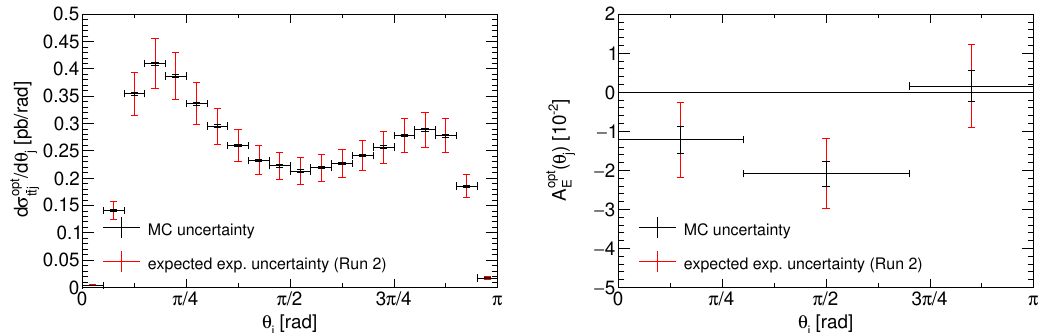
Figure 2 . Particle-level predictions of the di(cid:11)erential cross section d(cid:27) opt =d(cid:18) j in the single lepton t (cid:22) tj channel (left) and the energy asymmetry A opt (right) in three bins of (cid:18) j . The black vertical error bars E show the statistical Monte-Carlo uncertainty of the prediction due to limited number of generated events. The red vertical error bars show the expected experimental uncertainties in a future LHC measurement with 139 fb (cid:0) 1 of Run-2